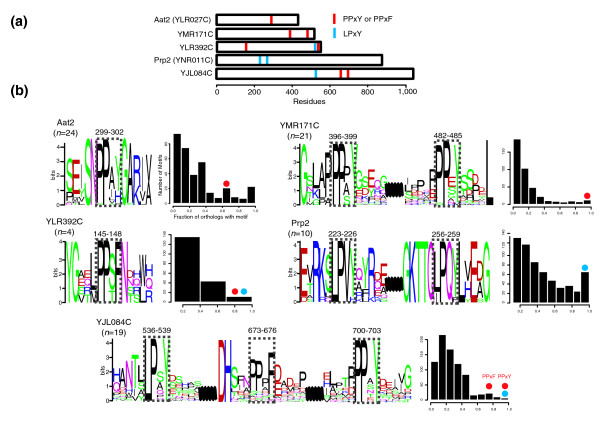
Phylogenetic conservation of the WW ligand motifs within yeast proteins. (a) Positions of primary sequence motifs within S. cerevisiae Aat2, Ymr171c, Ylr392c, Prp2, and Yjl084c. (b) Logo representations [68] of the conserved region within the set of orthologs. The number of orthologs in each set is indicated. Gray dashed boxes highlight the conserved motifs; numbers indicate the position of the motif within the S. cerevisiae protein. Histograms represent the level of conservation of all S. cerevisiae X-X-x-X sequence determinants within the set of orthologs. Colored circles mark the bins that contain the PPxY, PPxF and LPxY motifs.